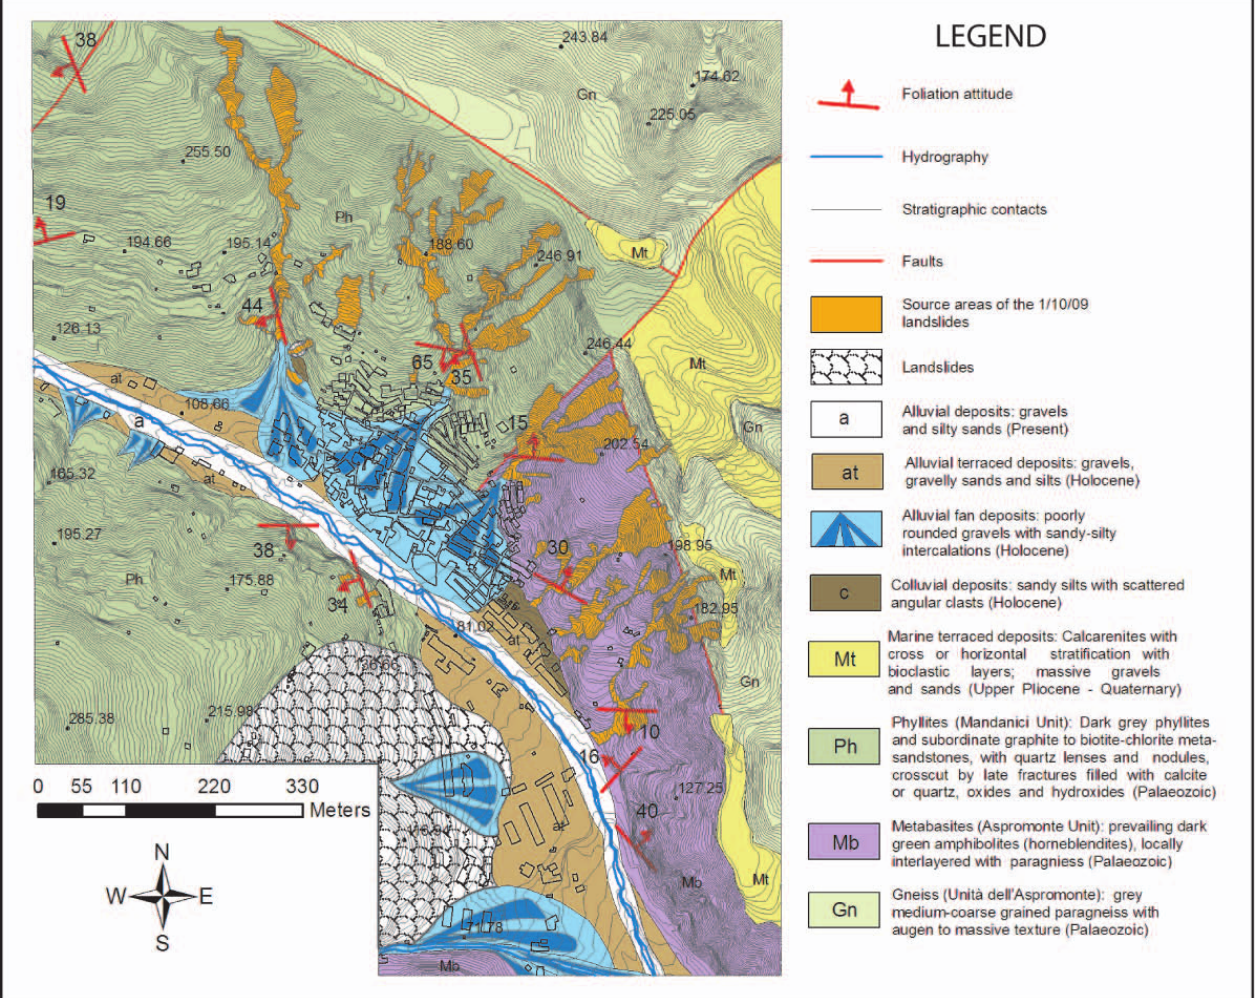
Fig. 5. Geologic map of Giampilieri, with location of 1 October 2009